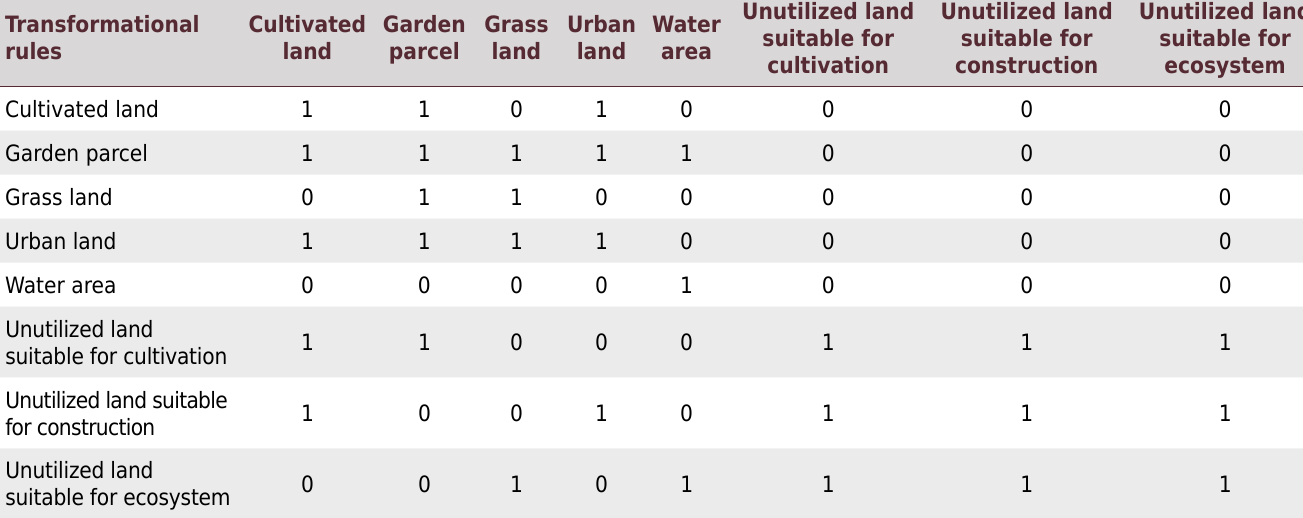
Table 7. Transformational rules among various types of land utilization for the dual model